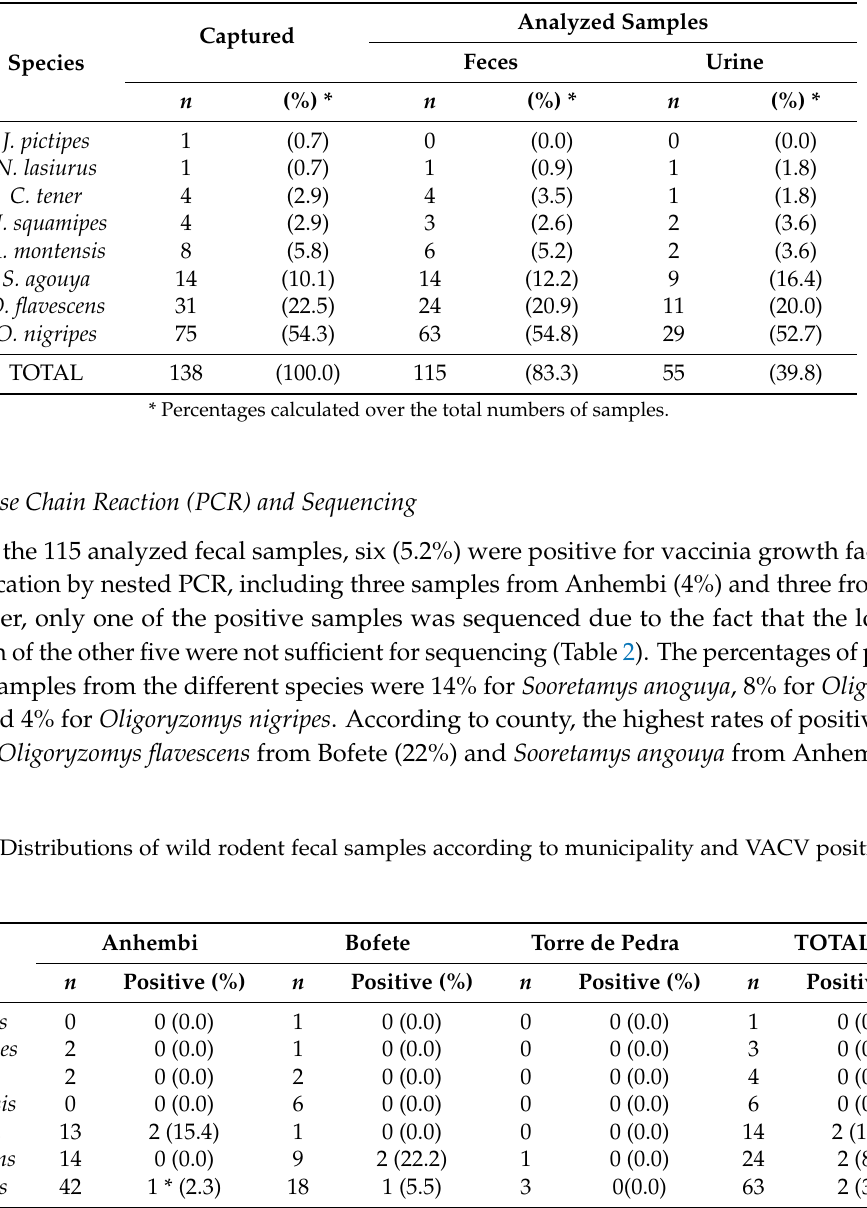
Table 1. Wild rodent species captured and clinical samples analyzed for presence of VACV in Brazil. Analyzed Samples Captured Feces Urine Species